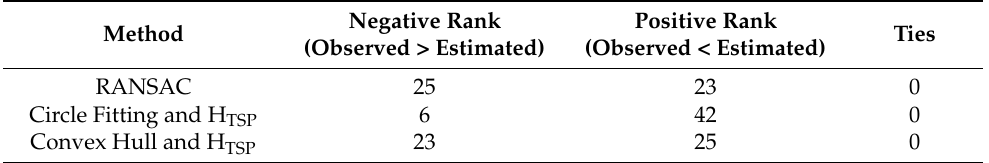
Table 6. Statistical summary of the observed and estimated total stem volume.